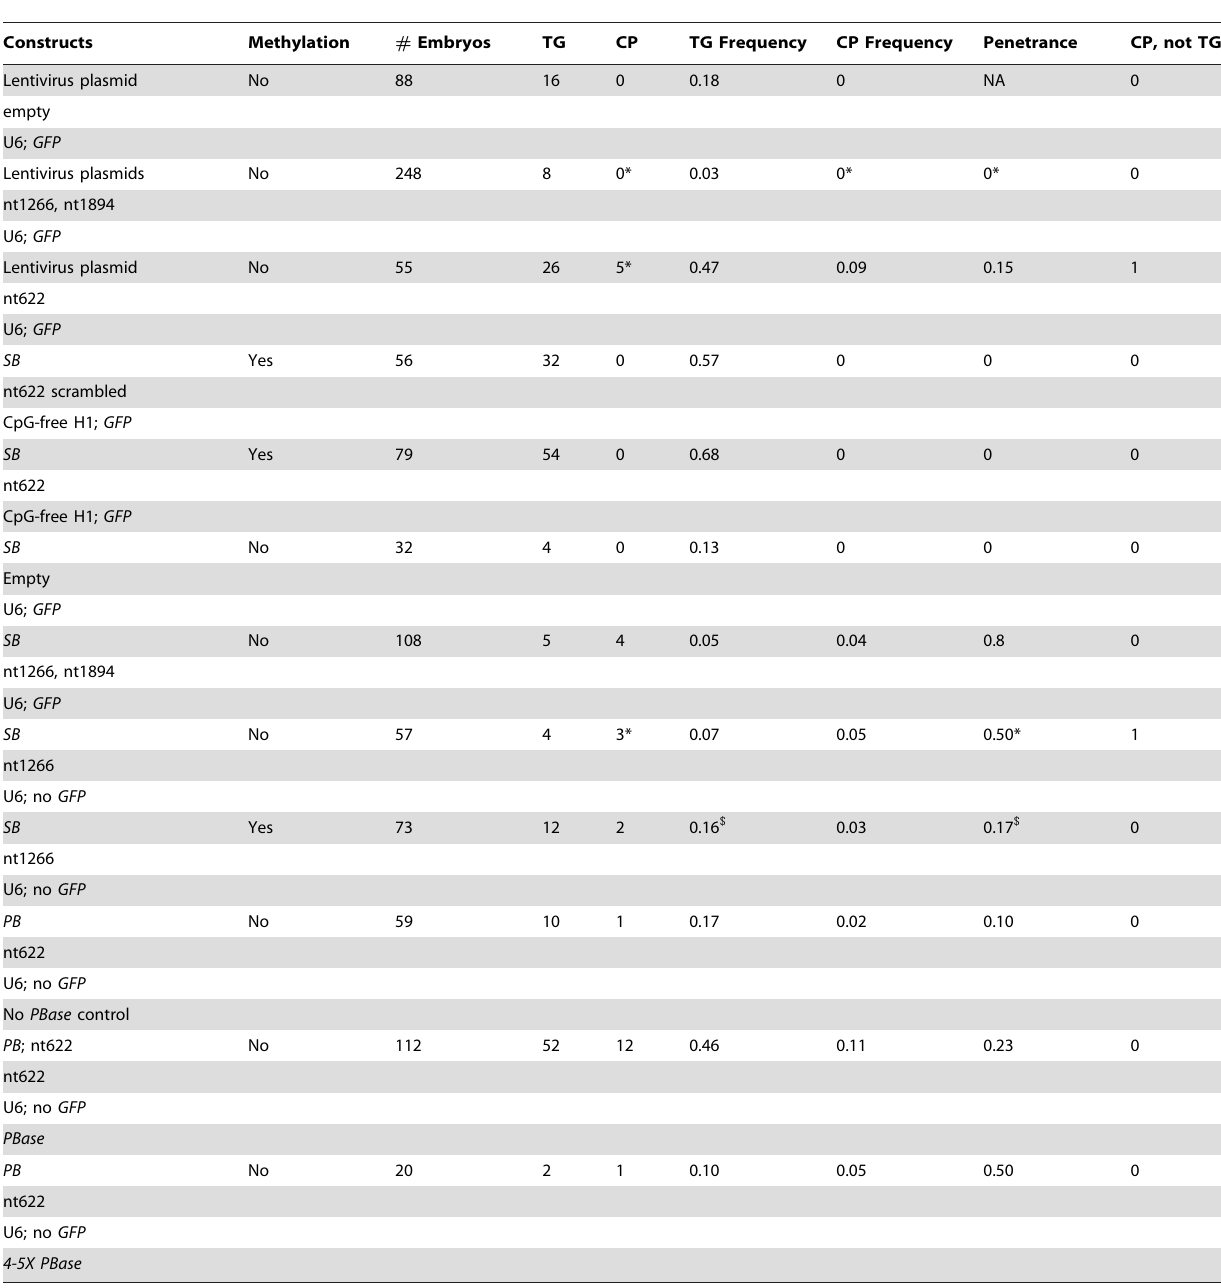
Table 2. Combined summary of transgenic RNAi injections.